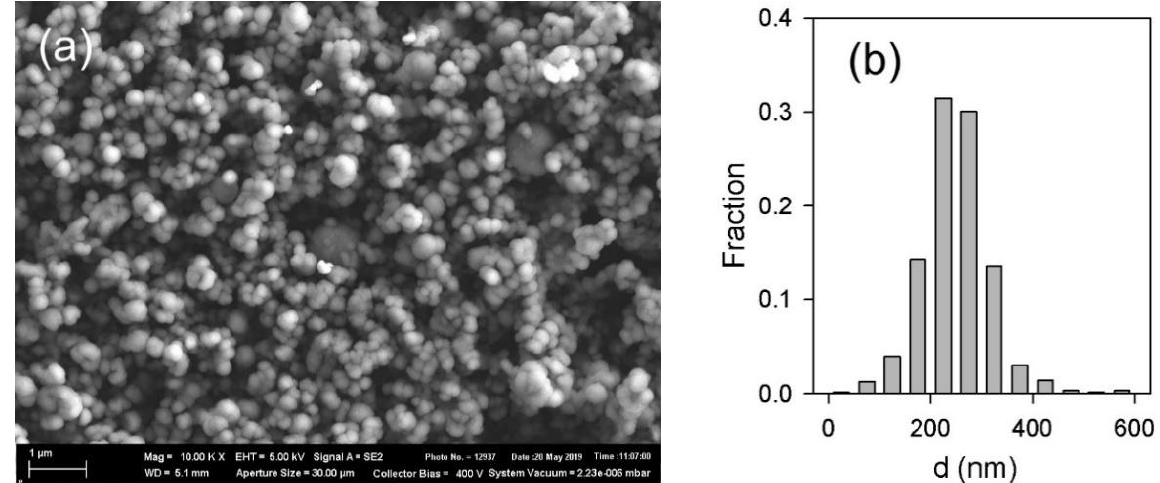
Figure 1. ( a ) SEM image of magnetite particles; ( b ) particle size distribution given by graphical image analysis of 632 particles in spherical approximation.